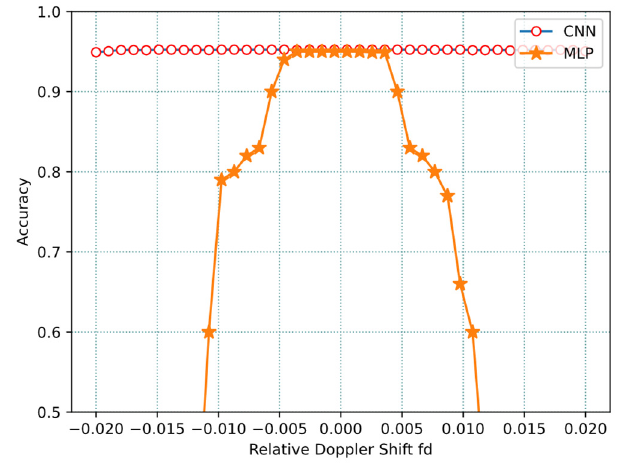
Figure 5. The performance of the proposed Siamese network for Doppler shifts.